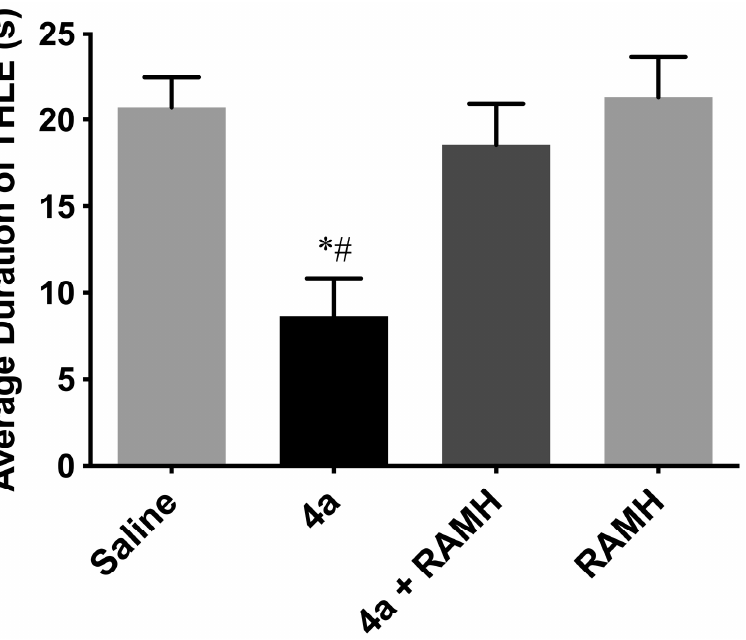
Figure 5. The protection of compound 4a (10 mg/kg, i.p.) against the maximal electroshock-induced seizures in mice pretreated with RAMH (10 mg/kg, i.p.). Data come from seven animals in each group and are shown as mean ± SEM in the figure. * p < 0.01 when compared to the control group (saline-treated), # p < 0.01 when compared to the combined group ( 4a + RAMH).